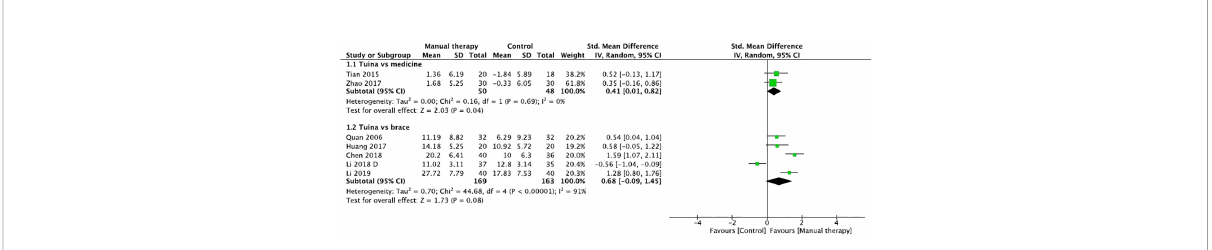
FIGURE 4 Forest plot of the effect of manual therapy for idiopathic scoliosis in disability.